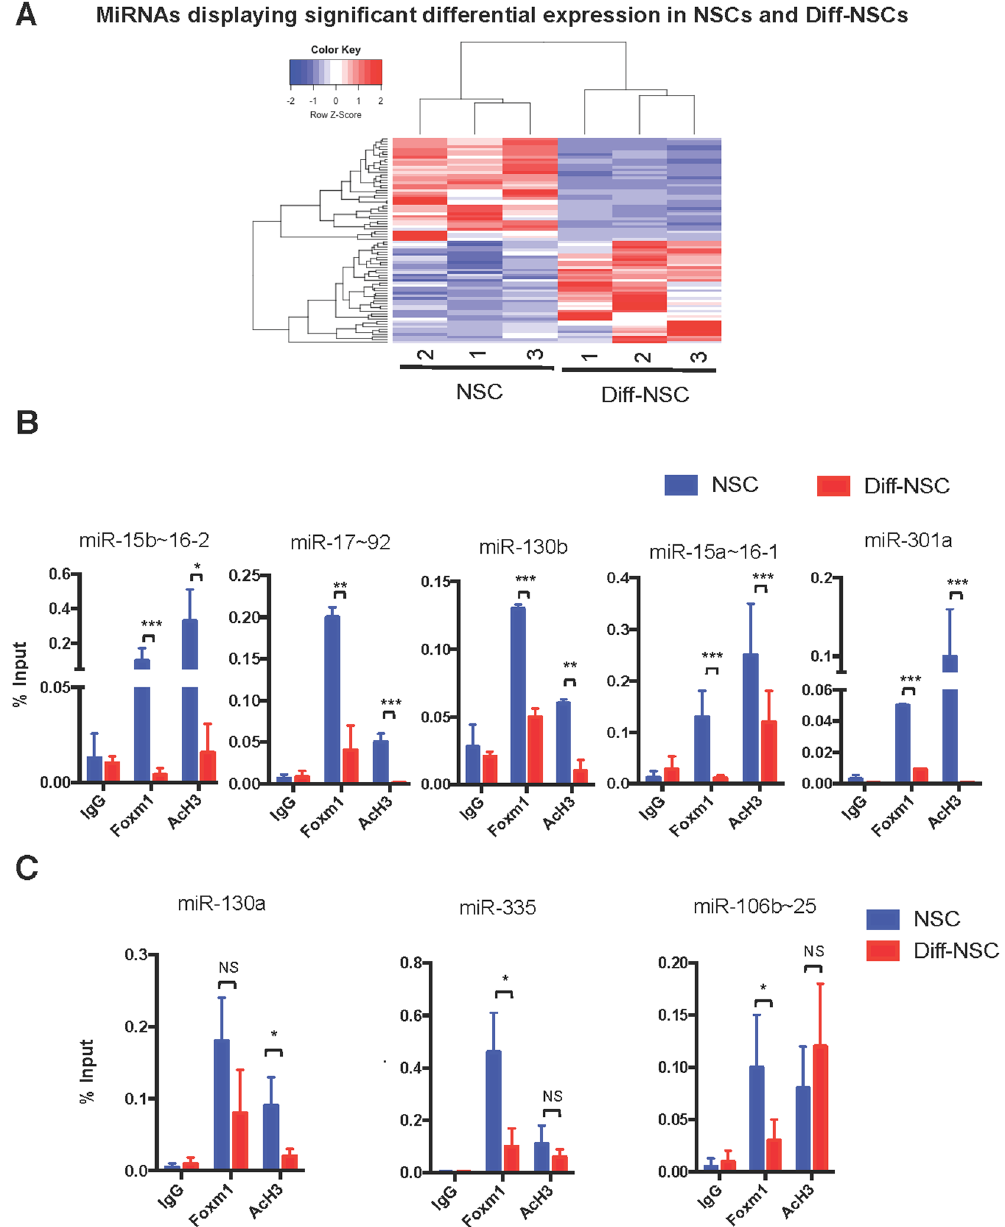
Figure 4. Foxm1 controls the transcription in P4 murine cerebellar NSCs of multiple miRNAs and miRNA clusters. ( A ) Heat map and dendrogram depiction of the 80 miRNAs displaying significant differential expression in NSCs before and after induction of differentiation. ( B , C ) qPCR-ChIP assays of NSCs and Diff- NSCs using anti-Foxm1 antibody and anti-acetyl-H3 antibody. Immunoprecipitation with IgG was performed as control. Eluted DNA was PCR-amplified with primers annealing to promoter regions of the miRNA genes of interest. Findings for miRNA candidates belonging to a cluster are based on assays of one representative cluster member. Results are expressed as fold induction versus input controls. B-actin was utilized as unrelated chromatin control and is presented in Supplementary Figure 6B. Bars represent the mean (SD) of three independent experiments. P values NSCs vs. Diff-NSCs (Mann–Whitney U test): Statistically significant ( B ) Foxm1: ** P < 0.01: 0.002204 (miR-17~92); *** P < 0.001: 0.000 (miR-15b~16-2), 0.0003471